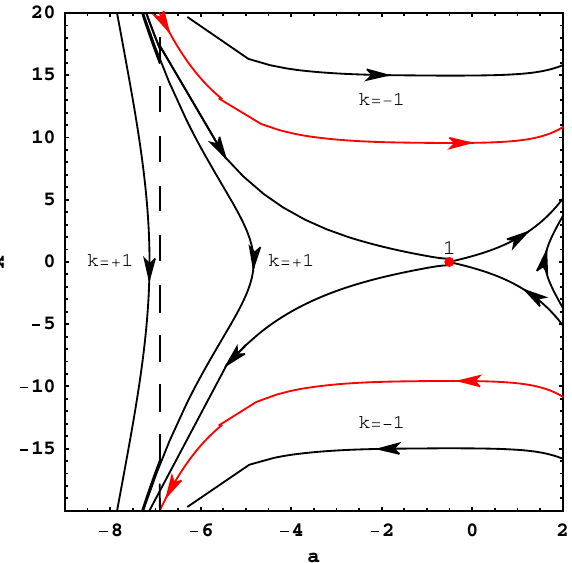
Fig. 4 The diagram presents the phase portrait for dynamical systems (44)–(47) for w = 1 and α < 2. The dashed line represents the gener- alised sudden singularities. Critical point (1) presents the static Einstein universe and is the saddle type. The scale factor a is presented in the logarithmic